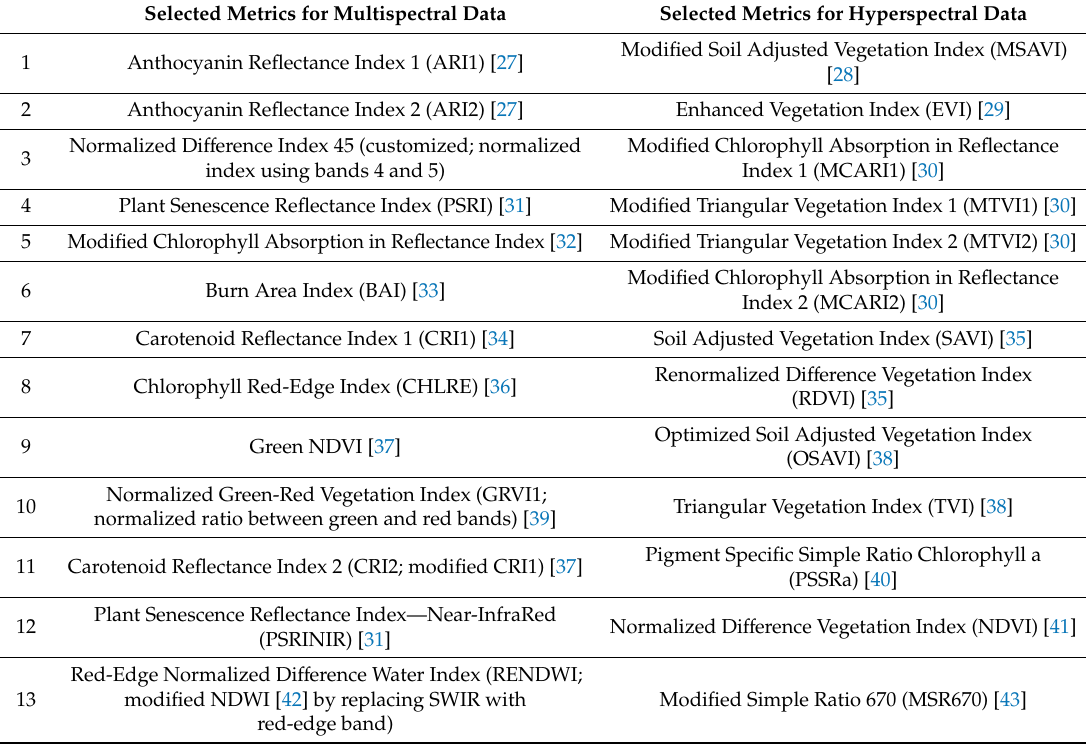
Table 4. List of selected metrics (left—multispectral data; right—hyperspectral data).